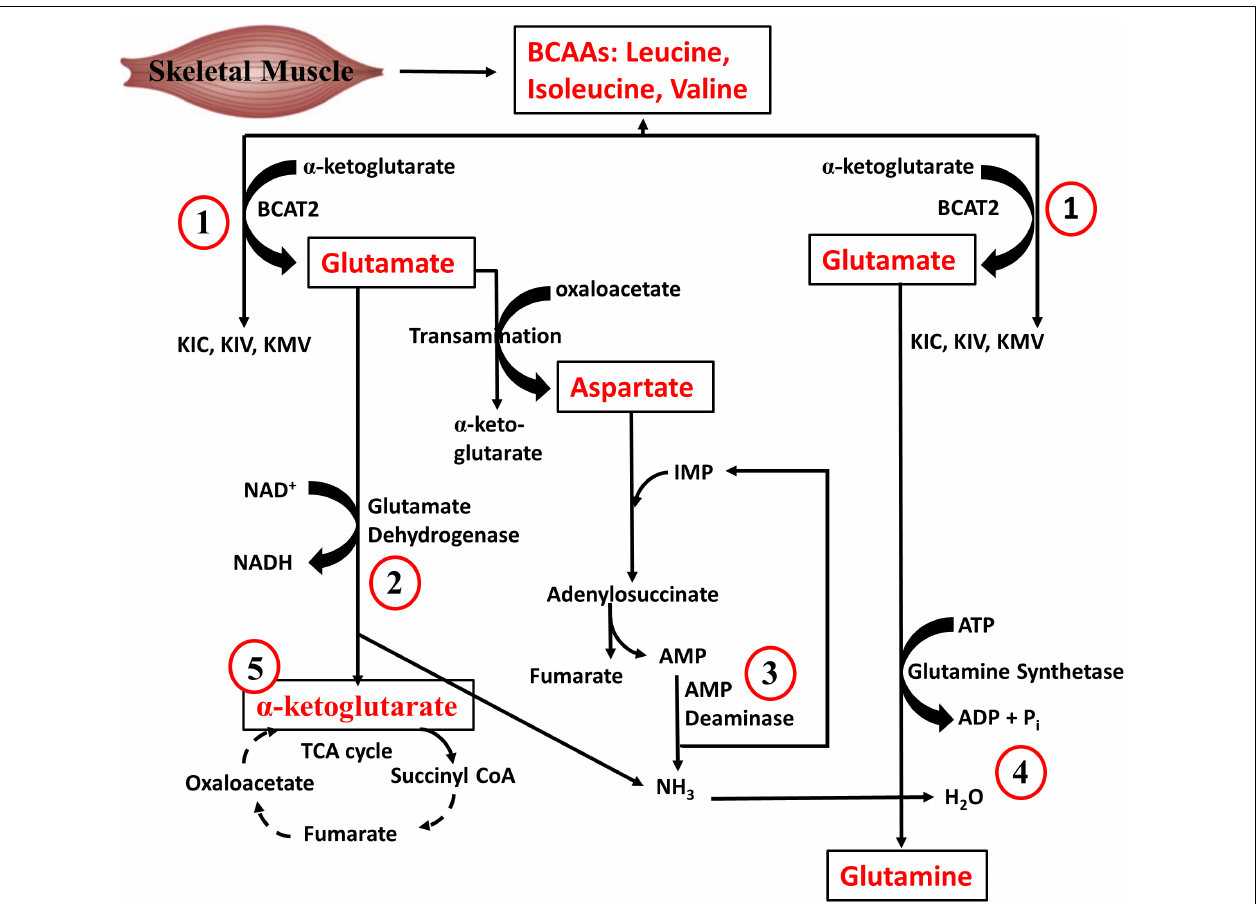
FIGURE 3 | Branched-chain amino acid metabolism in skeletal muscle. (1) BCAAs are transaminated with α -ketoglutarate by BCAA transaminase to generate glutamate. (2) Glutamate deamination yields α -ketoglutarate and ammonia. (3) During exercise, AMP is generated from ATP degradation in the skeletal muscle. The muscle AMP deaminase reaction also forms ammonia. (4) Glutamine is formed from ammonia and glutamate, a reaction catalyzed by glutamine synthetase. (5) The α -ketoglutarate formed by glutamate dehydrogenase can anaplerotically enter the TCA cycle. Re-drawn and modified from Groper and Smith (2013).